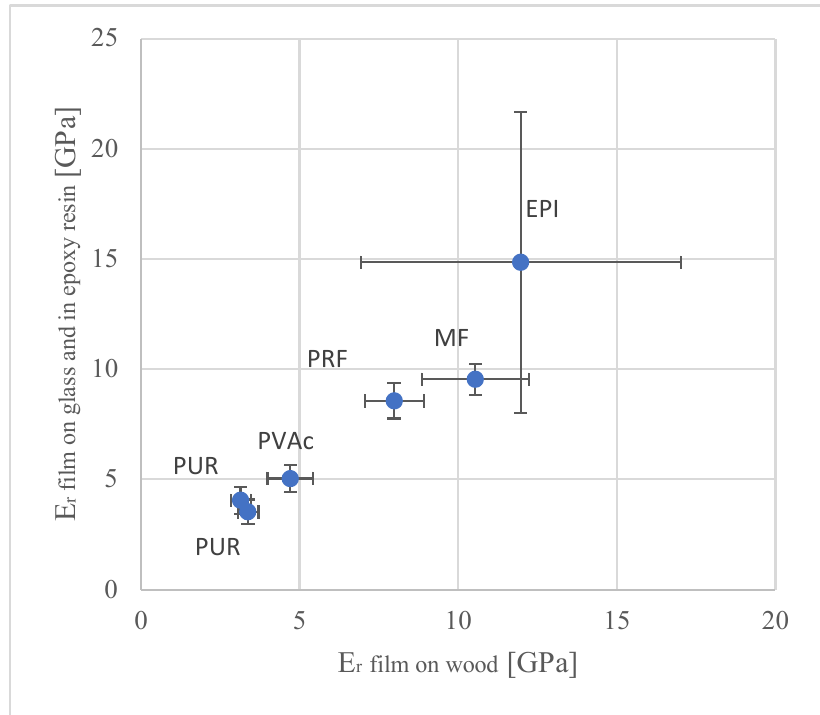
Figure 5. Comparison of the hardness from the nanoindentation of the pure polymer films and polymers in the adhesive on the wood (error bars correspond to the standard deviation).